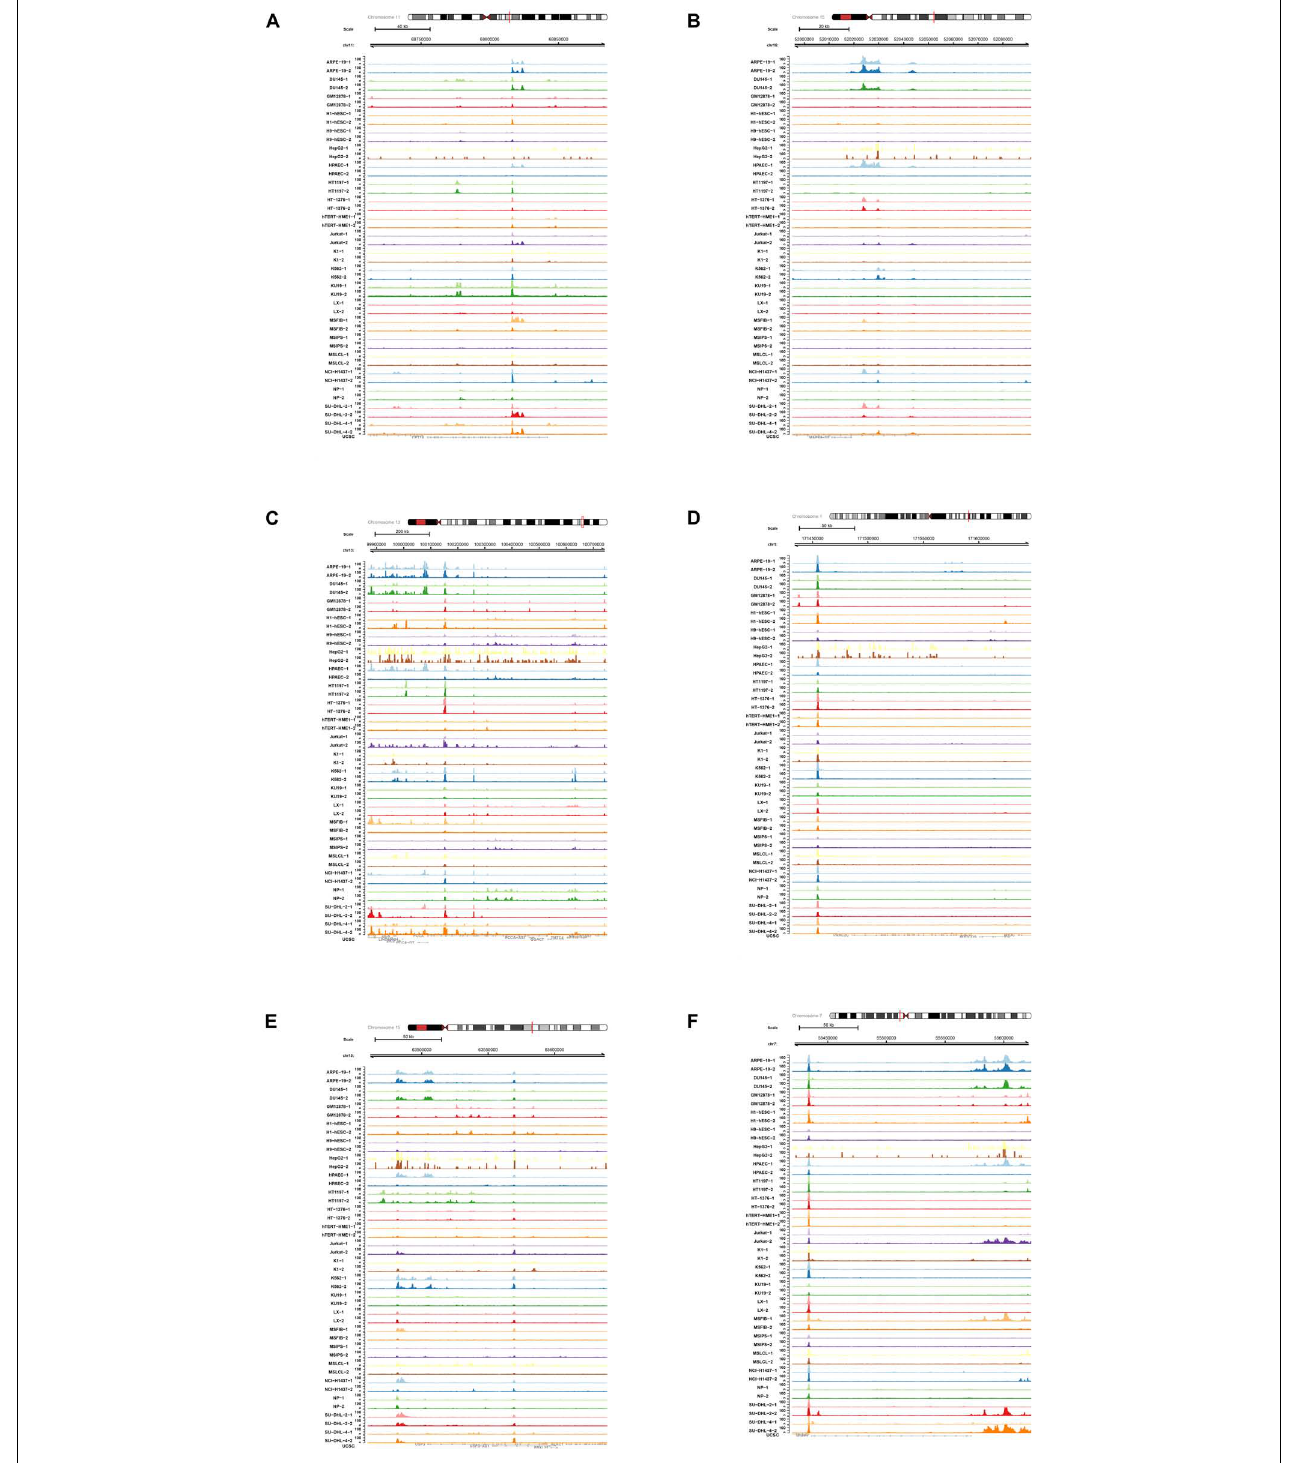
FIGURE 9 | Chromatin immunoprecipitation sequence (ChIP-seq) analysis of key differentially expressed enhancer RNAs (DEeRNAs). (A) In ChIP-seq data of H3K27ac, multiple binding peaks were found in CPT1A sequences. (B) In ChIP-seq data of H3K27ac, multiple binding peaks were found in MAPK6 sequences. (C) In ChIP-seq data of H3K27ac, multiple binding peaks were found in PCCA sequences. (D) In ChIP-seq data of H3K27ac, multiple binding peaks were found in PRRC2C sequences. (E) In ChIP-seq data of H3K27ac, multiple binding peaks were found in USP3 sequences. (F) In ChIP-seq data of H3K27ac, multiple binding peaks were found in vesicular overexpressed in cancer prosurvival protein 1 (VOPP1) sequences.